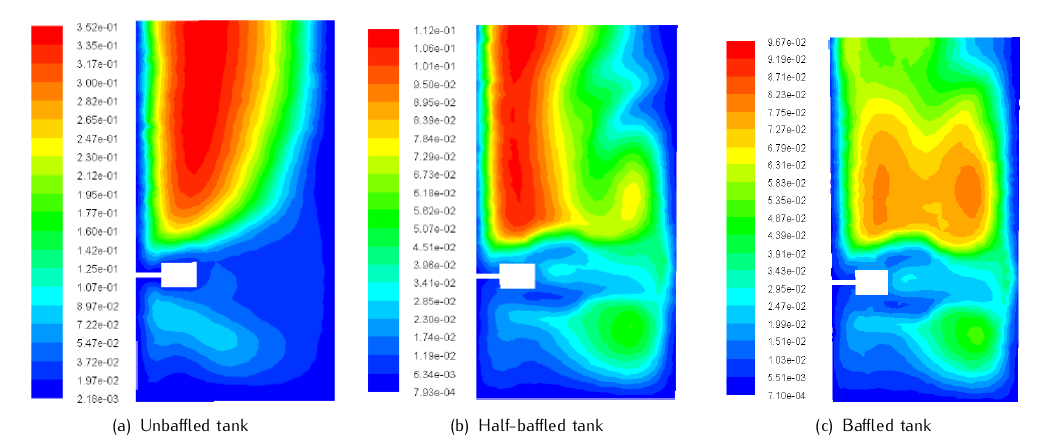
Figure 12. Distribution of the turbulent viscosity in the r-z plane.